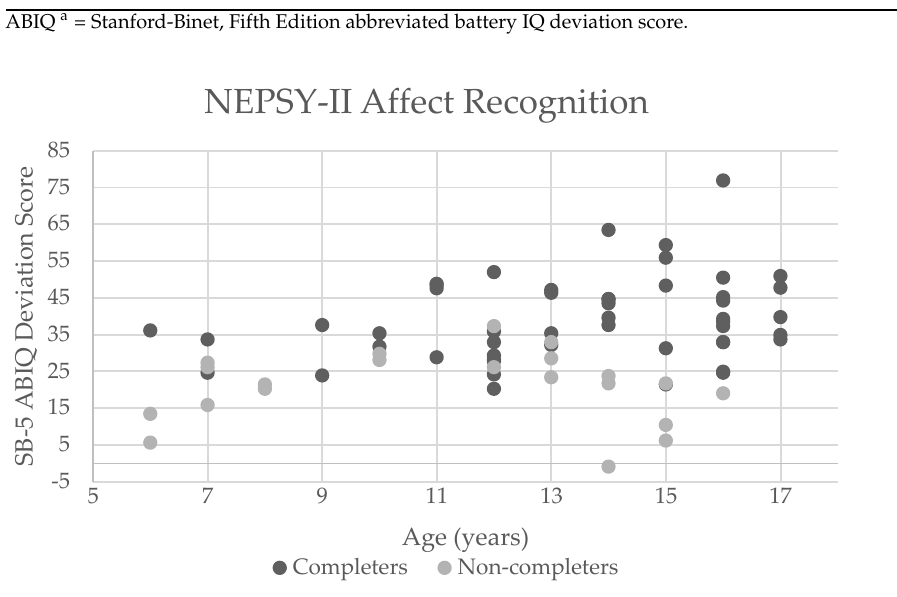
Figure 1. Chronological age in years and Stanford-Binet, Fifth Edition abbreviated battery IQ deviation scores of completers and non-completers for NEPSY-II Affect Recognition. Negative score represents a raw score more than 3.33 standard deviations below the mean that for the participant’s age